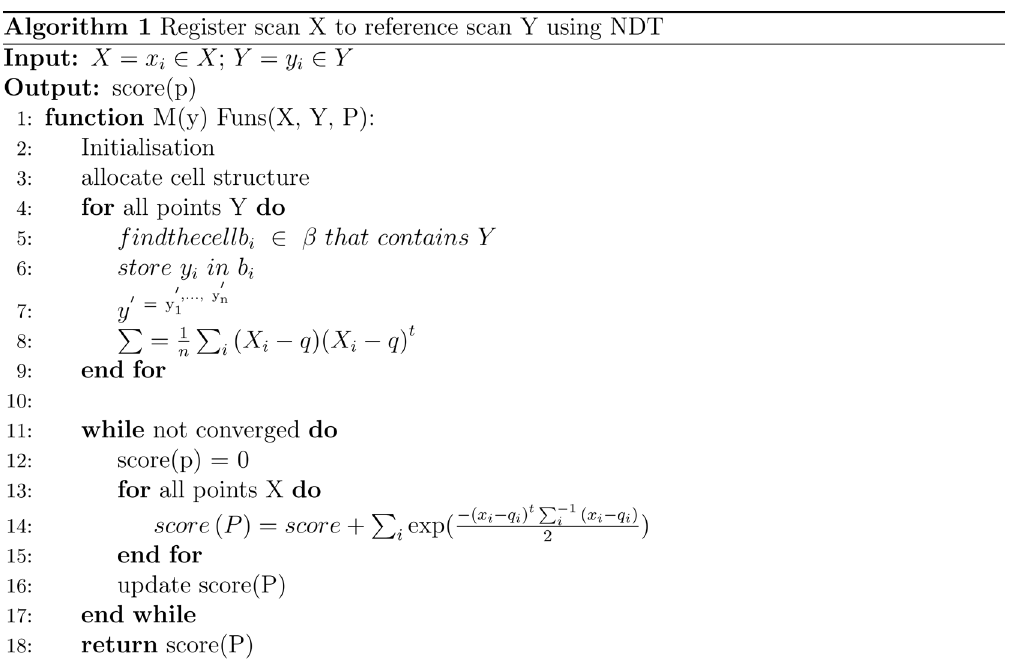
Figure 7. Pseudocode for NDT registration algorithm.